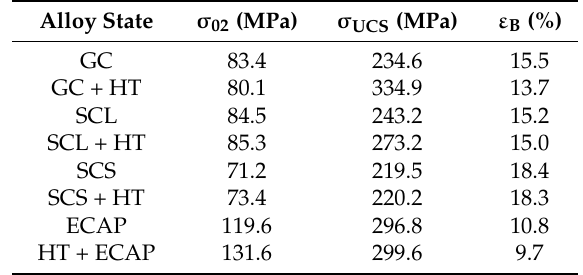
Table 4. Mechanical characteristics of Mg-3Zn-2Ca alloy processed by different methods obtained in compression: yield stress, σ 02 , ultimate compression strength, σ UCS , and strain to fracture, ε B .